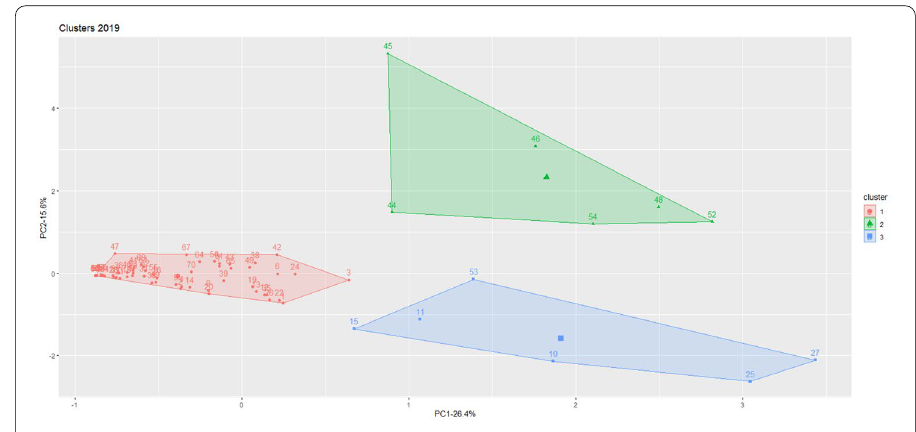
Fig. 7 Clusters of industries,